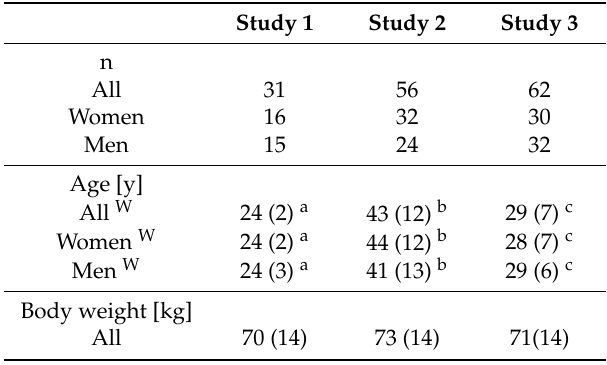
Table 2. Baseline characteristics of the three study